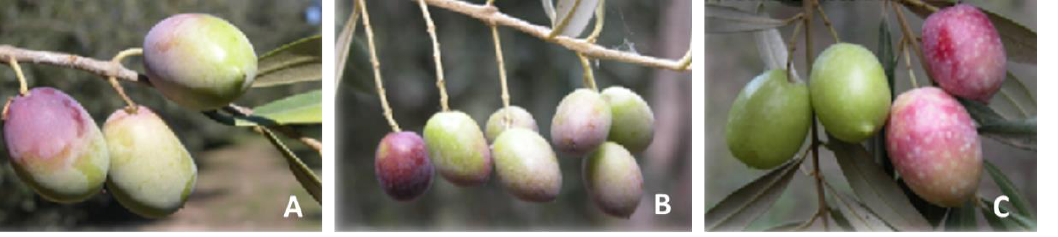
Figure 1. Olive branch with drupes of the three olive cultivars ( A = Carolea; B = Leccino; C = Nocel- lara Messinese).